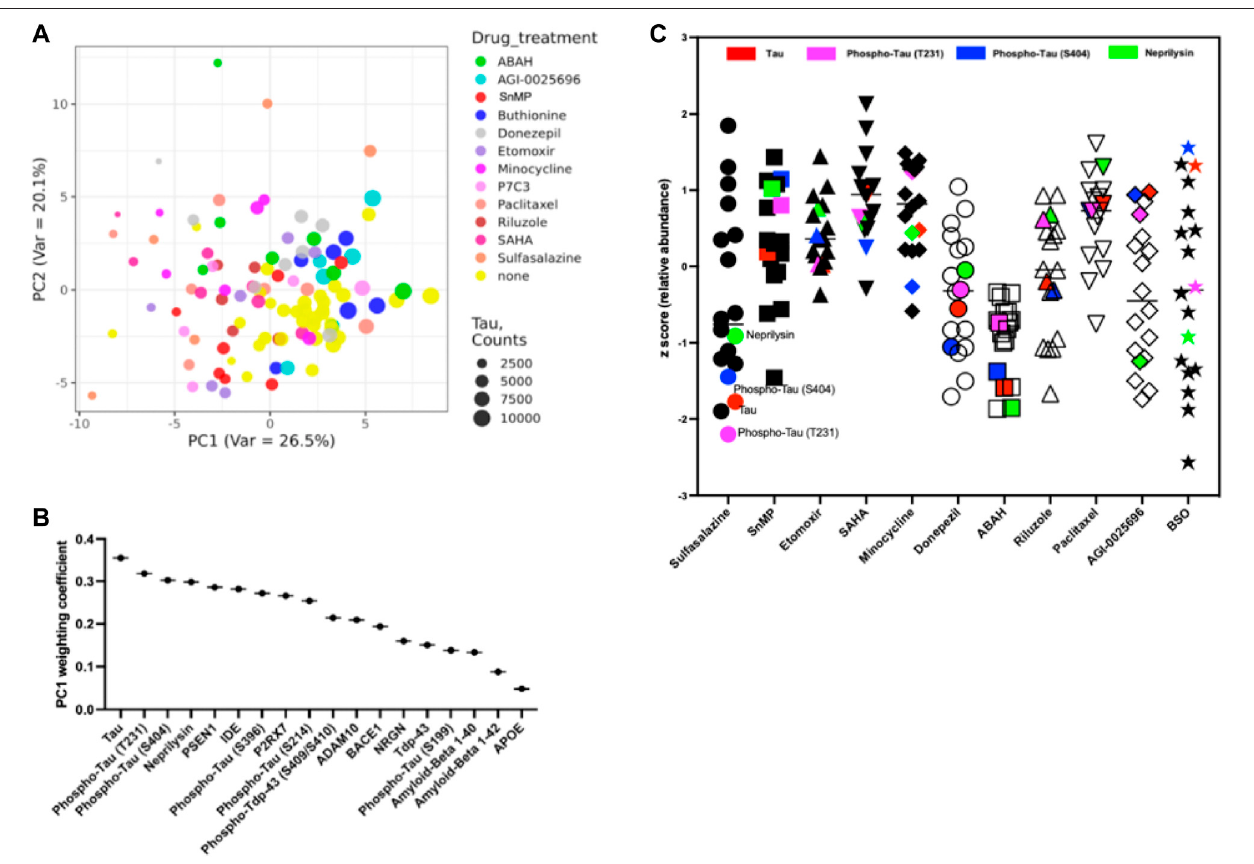
FIGURE 7 | (A) Principal component analysis reveals distinct phenotype of drug activity at t = 7 days (B) Identi fi cation of most signi fi cantly affected individual markers from principal component from all drugs tested in TG model (C) Drug effects in reduction of AD-associated markers (z-score). Highlighted are key markers of tauopathy (Tau: red; phospho-Tau T231: magenta; phospho-Tau T404: blue; and Neprilysin: